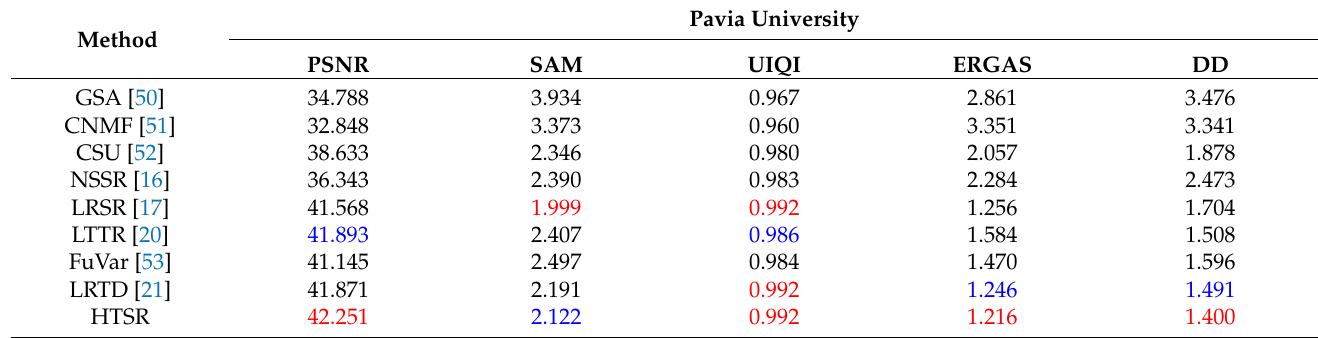
Table 2. Quantitative metrics of the competitive methods on the Pavia University